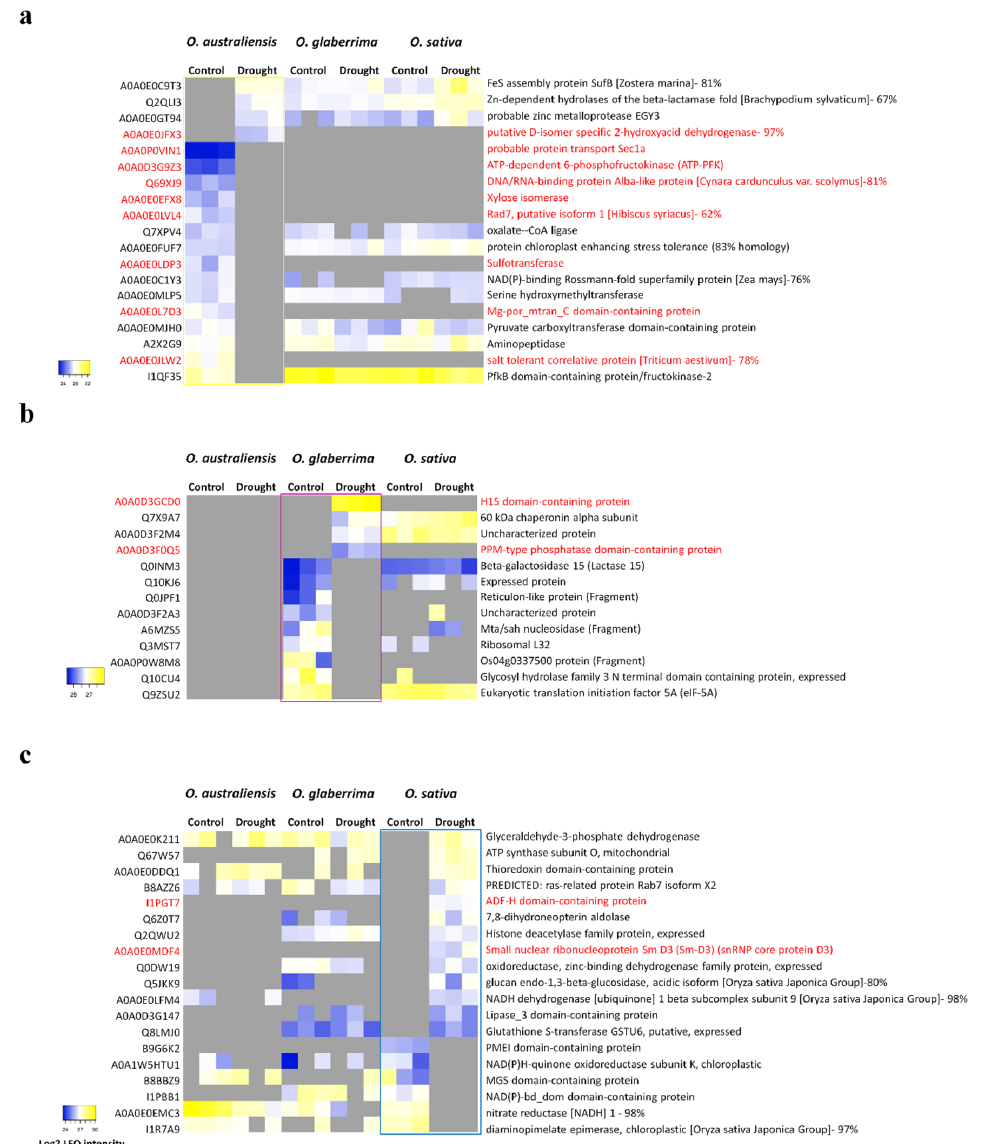
Figure 4. Heatmaps showing relative levels of accumulation of proteins exclusively identified under control and drought stress conditions in ( a ) O. australiensis , ( b ) O. glaberrima , and ( c ) O. sativa . The relative protein accumulation profiles in the other species are also shown. Protein names highlighted in red indicate proteins found uniquely in the indicated species.